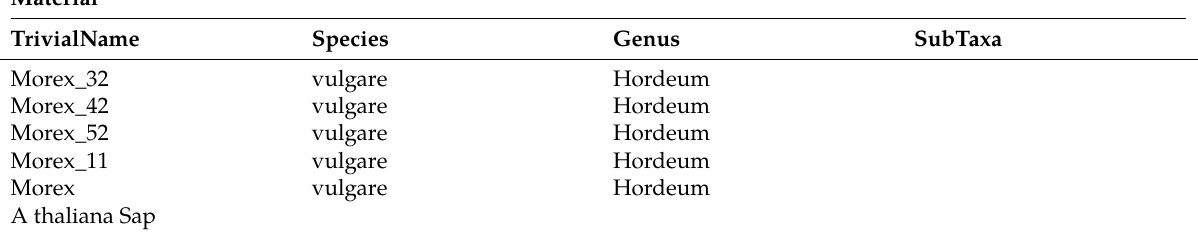
Table 2: Non-homogeneous and incomplete material naming. Material